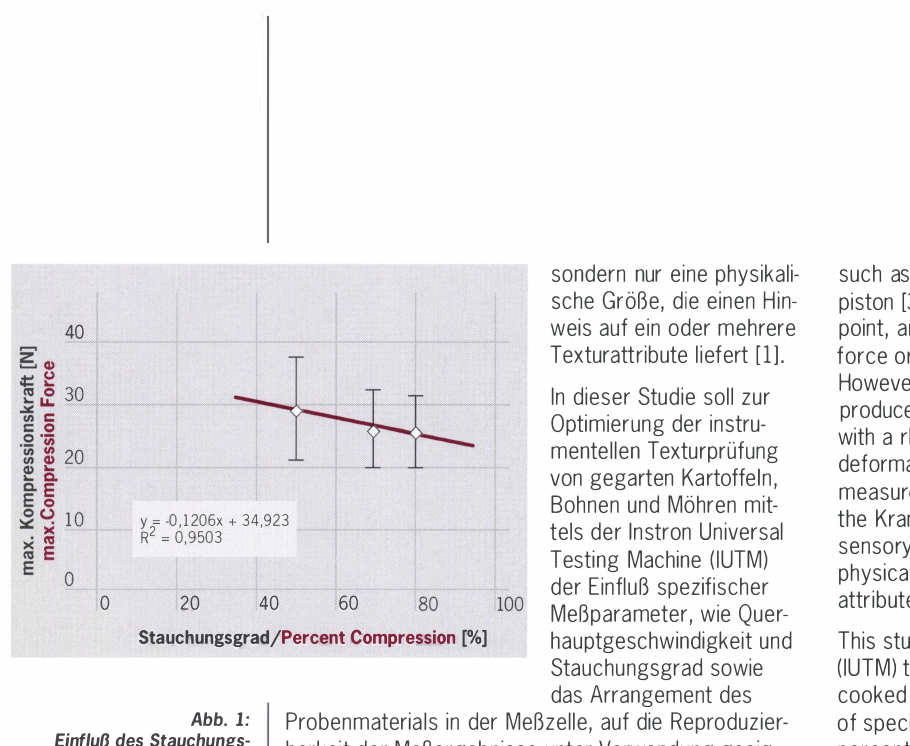
Fig. 1: Effect of percent compression on the maximum compression force (potatoes, n =